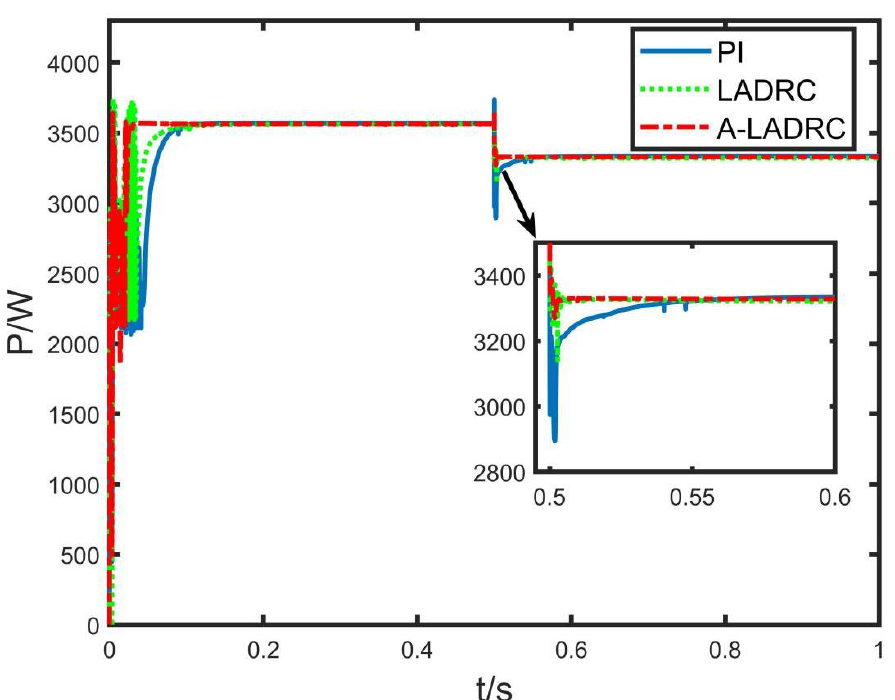
Figure 16. Output power of photovoltaic array when PV1 temperature is changed.